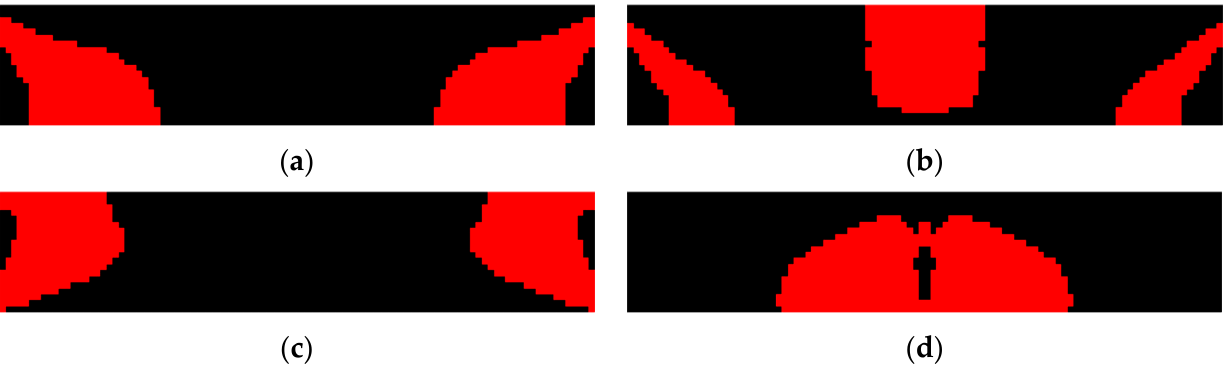
Figure 8. Open ‐ circuit voltage enhanced designs for variant excitation frequencies. ( a ) f = 4 kHz; ( b ) f = 6 kHz; ( c ) f = 10 kHz; ( d ) f = 16 kHz. Table 3. The optimized results of the open ‐ circuit voltage enhanced designs.